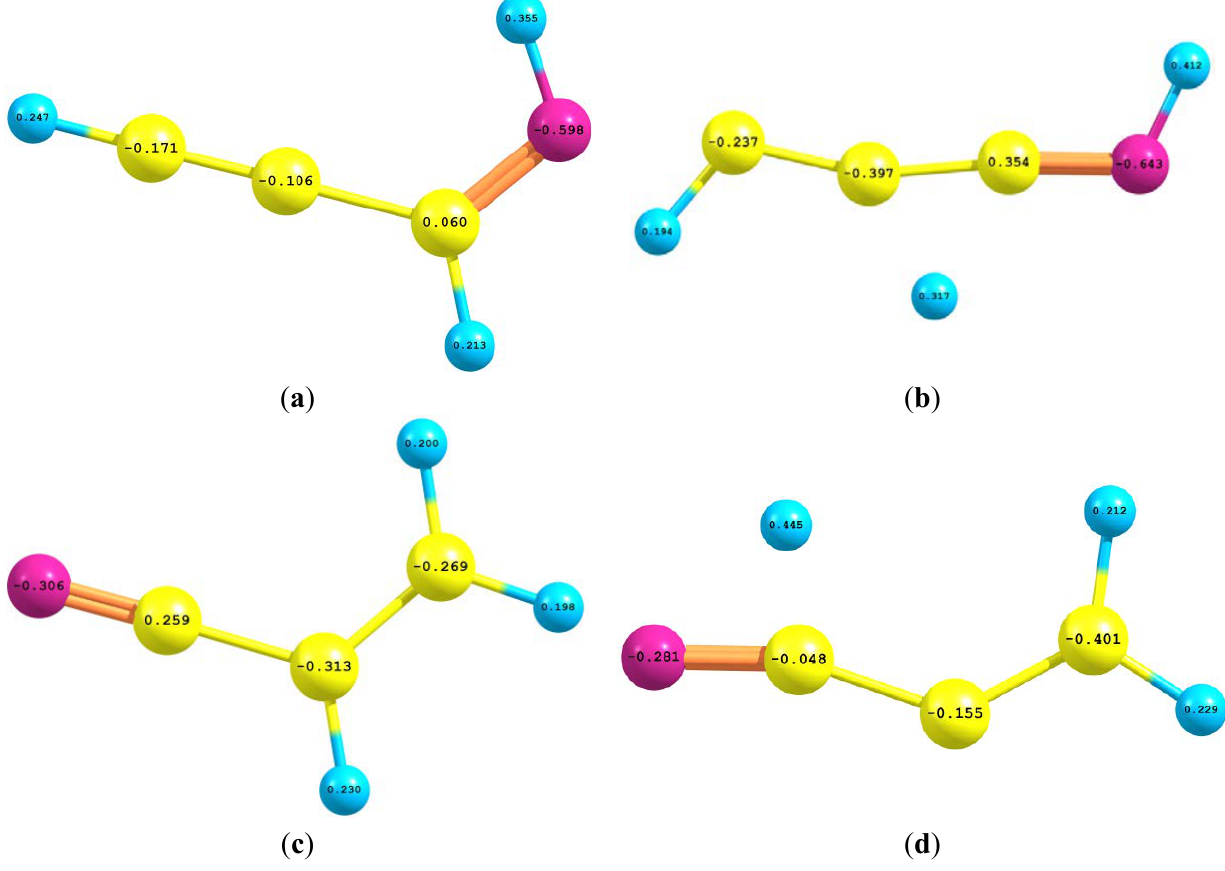
Figure 4. The NBO charge distribution of ( a ) Z-prop-2-ynylideneamine (II); ( b ) TS2; ( c ) vinyl cyanide (IV) and ( d ) TS1 which were calculated using B3LYP/aug-cc-pvdz level of theory. The migrating hydrogen atom acquired a positive charge (+0.213e) in II and an intensified charge (+0.317e) in TS2 while it acquired a positive charge (+0.230e) in IV that was condensed (+0.445e) in